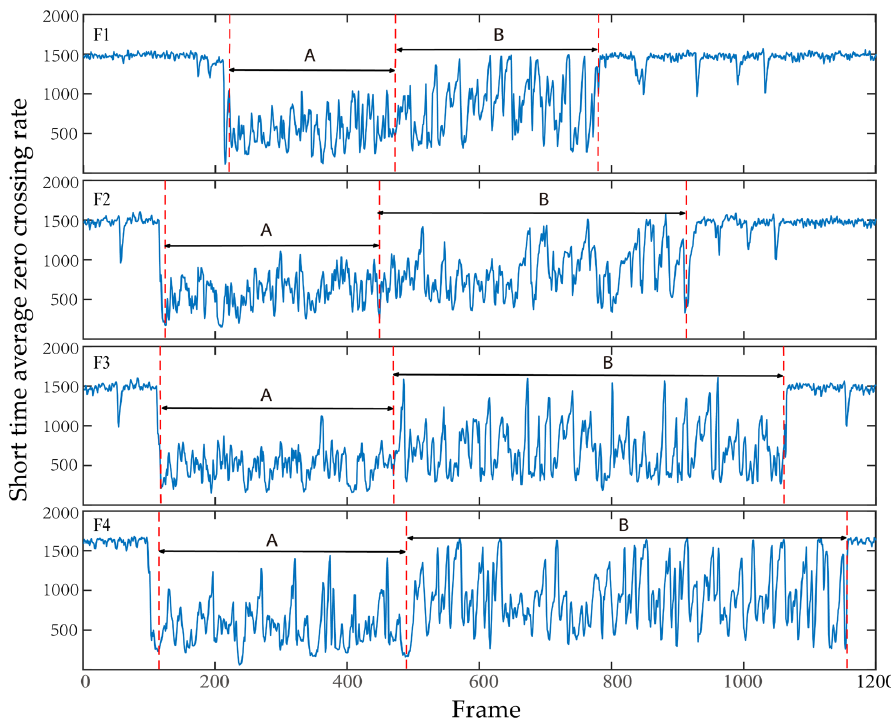
Figure 4. Short-term average zero crossing rate of feeding acoustic signal of largemouth bass with different breeding densities (A is the ingestion stage; B is the chewing stage): F1 represents the experimental group of breeding density of 4; F2 represents the experimental group of breeding density of 8; F3 represents the experimental group of breeding density of 12; F4 represents the experimental group of breeding density of 16).